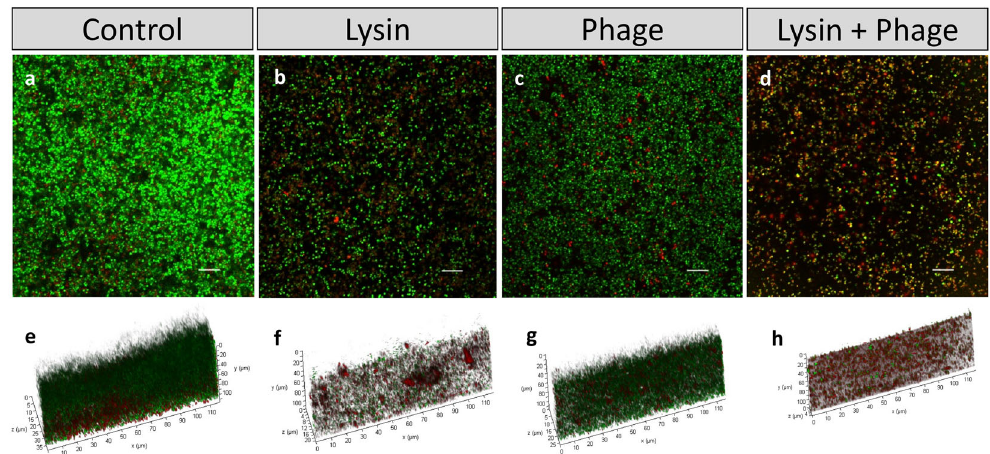
Fig. 2 CLSM images of LIVE/DEAD-stained S. aureus V329 24-h-old bio fi lms after different treatments. Preformed S. aureus V329 bio fi lms were treated for 24 h at 37 °C with TSB alone ( a and e ), 8 µM CHAPSH3b ( b and f ), 10 9 PFU/ml of phage phiIPLA-RODI ( c and g ) or a combination of 8 µM CHAPSH3b and 10 9 PFU/ml of phage phiIPLA-RODI ( d and h ). Green cells were intact cells, whereas eDNA and cells with compromised cell-envelope integrity were stained in red. Scale bars represent 10 µm.